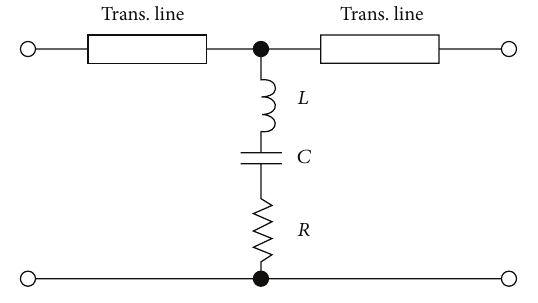
Figure 8: The equivalent circuit of the microswitch.